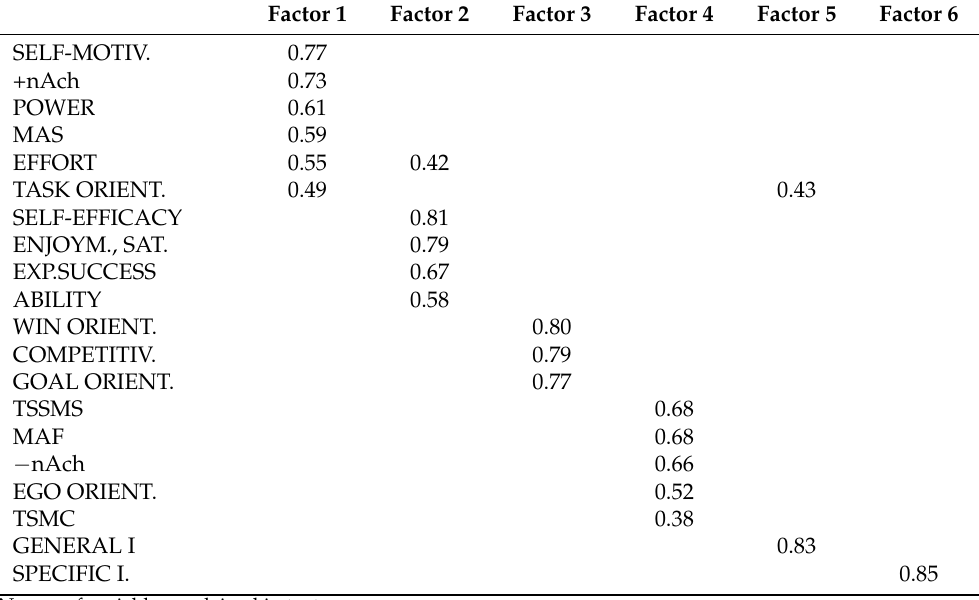
Table 6. Saturation of factors with manifest motivation variables (only correlation coefficients >